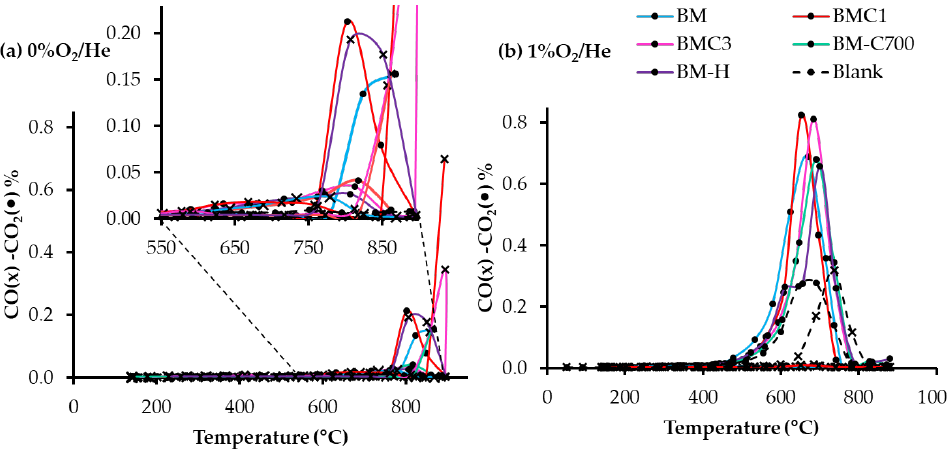
Figure 9. CO (x) and CO 2 ( · ) emission profiles in TPR conditions: ( a ) in He and ( b ) in 1% O 2 /He for BaMNO3 catalysts.